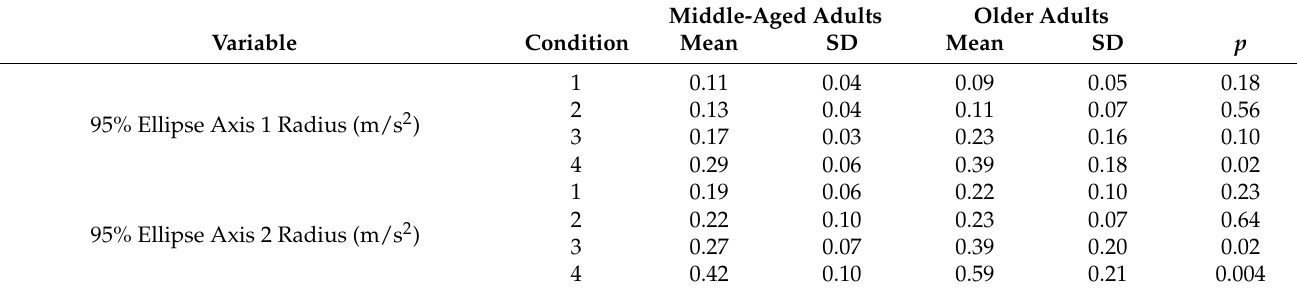
Table A4. Group by Condition post-hoc for balance variables demonstrating a significant interaction between Middle-aged Adults and Older Adults. Means and SD are presented as well as post-hoc analysis p -values for each variable and condition. Condition 1: Eyes open, Firm Surface; Condition 2: Eyes Closed, Firm Surface; Condition 3: Eyes Open, Compliant Surface; Condition 4: Eyes Closed, Compliant